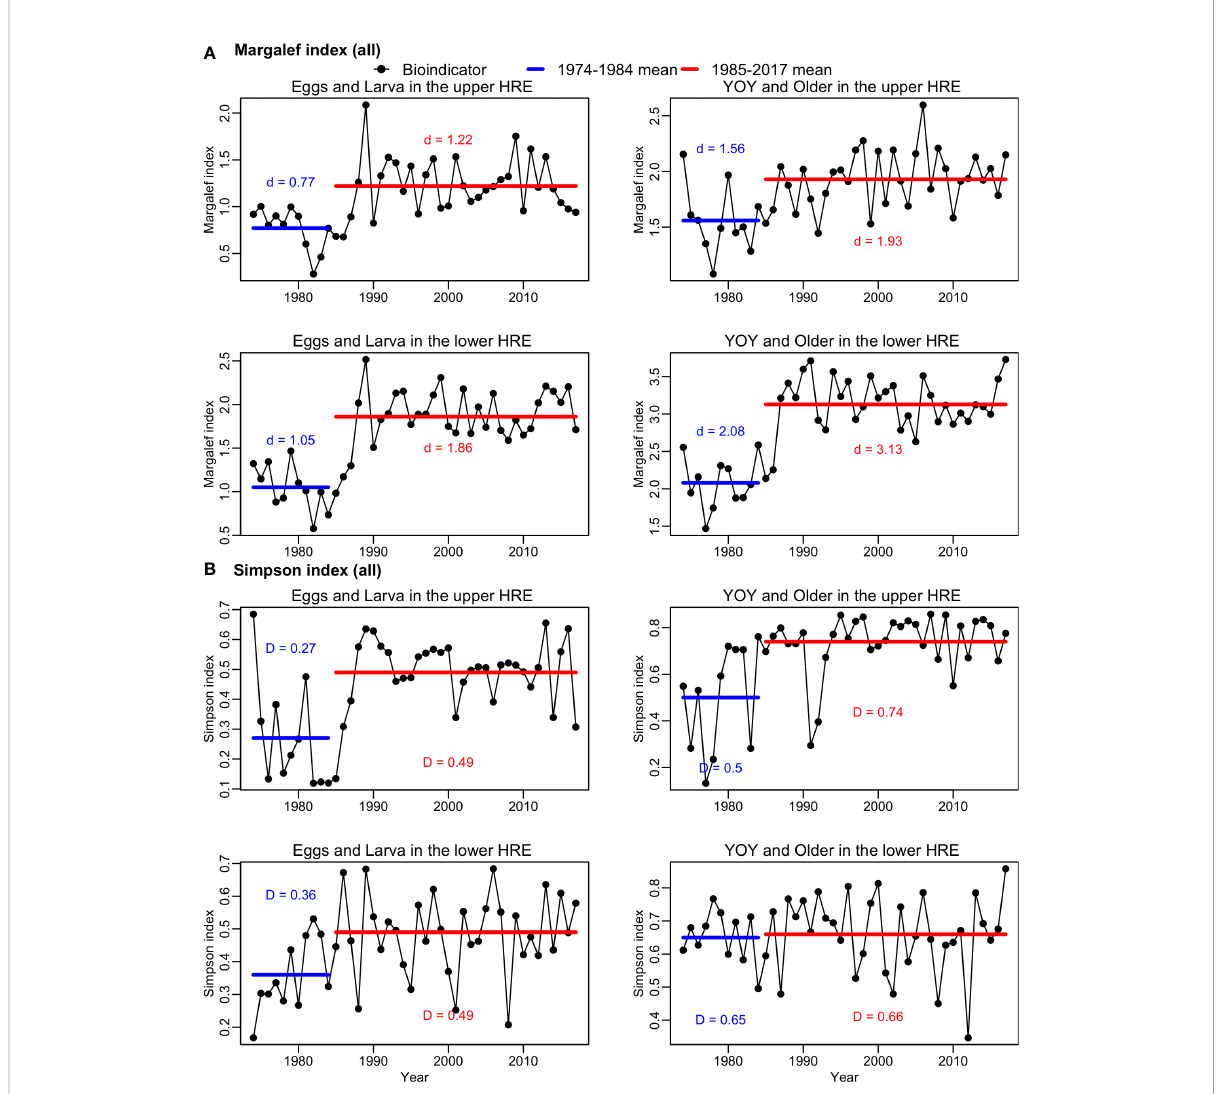
FIGURE 4 Time series of (A) Margalef index ( d all ) and (B) Simpson index ( D all ) for all species of early (eggs and larva) and older (young-of-year [YOY] and older) life stages during May-July from 1974-2017 in the upper and lower Hudson River Estuary (HRE). The blue horizontal lines indicate the average numbers of species in phase 1 (1974-1984), and the red horizontal lines indicate the average numbers of species in phase 2